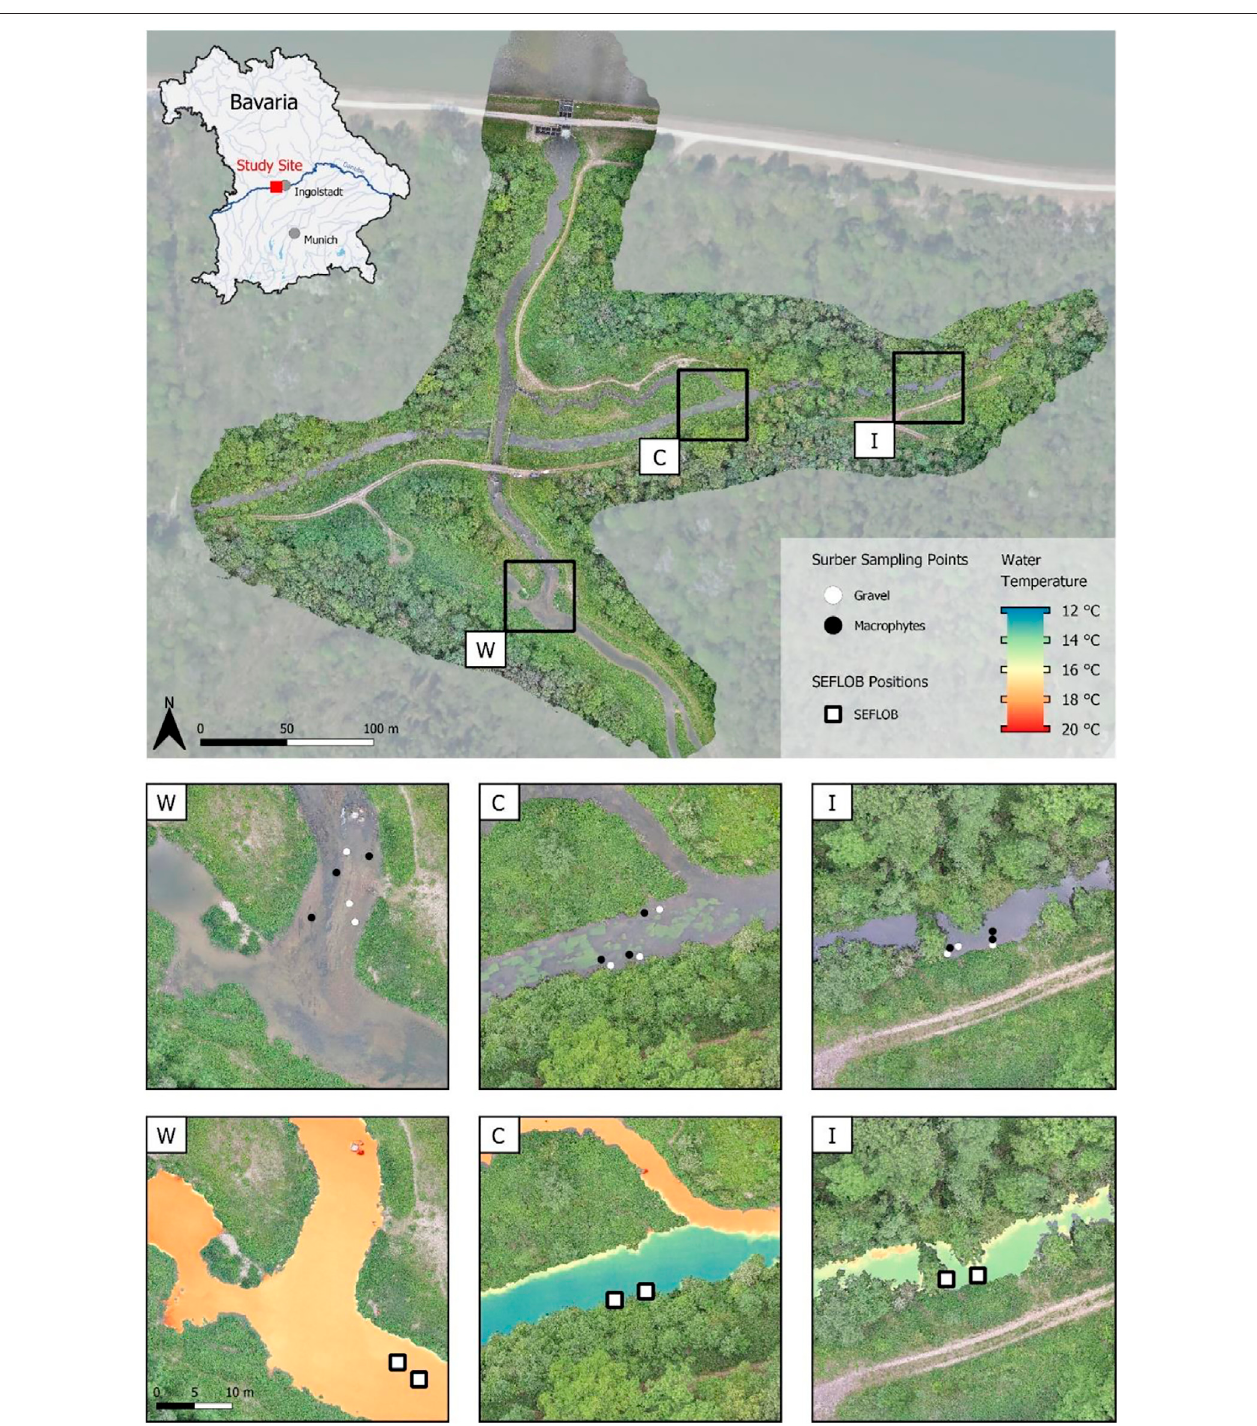
FIGURE 2 | Overview of the study area with referenced thermal regions and habitats. Surber samples were taken at marked white and black dots (GR- and MP- dominated habitats, respectively), displayed in the top warm = W, C = cold and I = intermixed panels. The second row of W, C, and I panels displays the thermal regime assessed in spring using UAV thermal imaging before the sampling started (26 May 2020) with noticeable differences in water temperature between habitats. Base orthophoto: Landesamt für Digitalisierung, Breitband und Vermessung (2020).